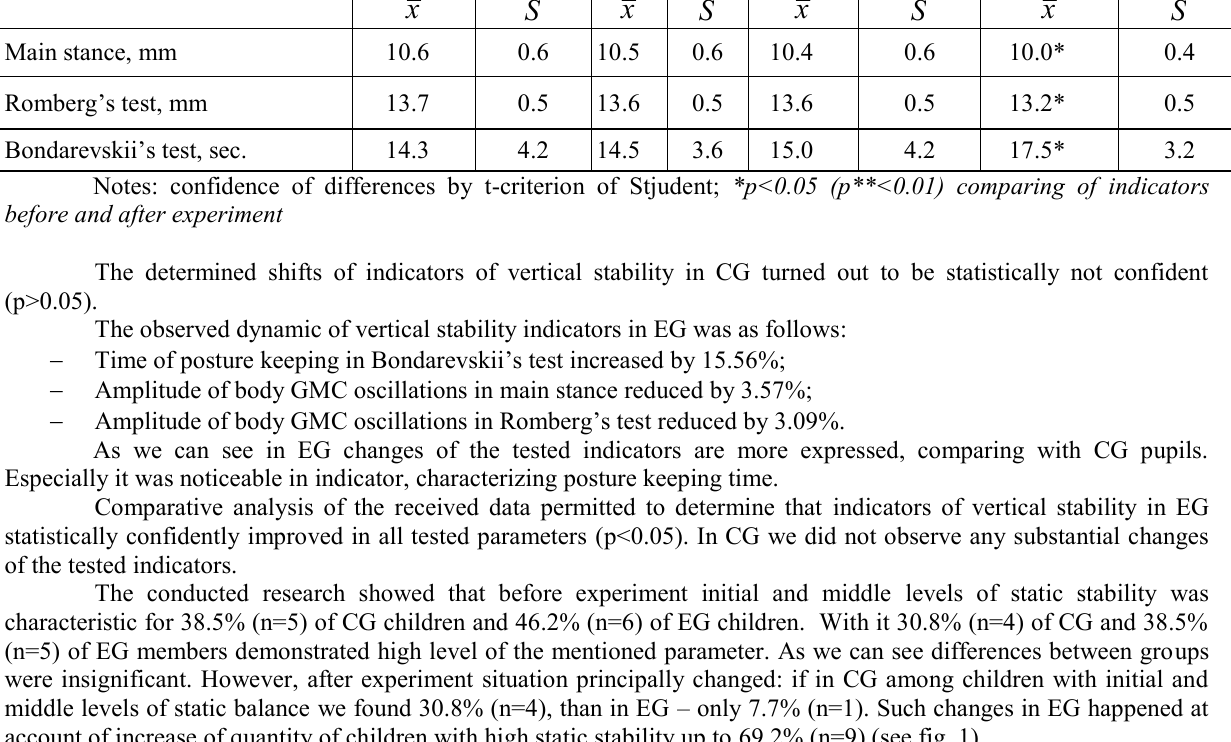
Amplitude of body GMC of children with hearing deprivations before and after experiment, (n=26) Control group, (n=13) Experimental group, (n=13) Description of test Before After Before